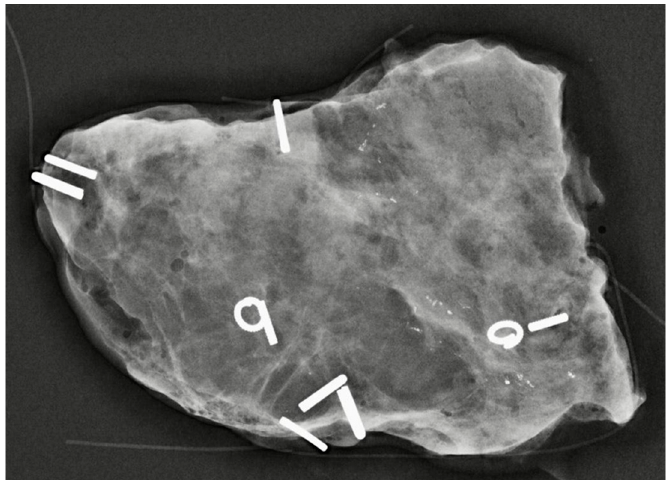
Figure 2. Intra-operative specimen mammogram showing residual micro-calcification after NST for triple-positive invasive breast cancer associated with DCIS with orientation staples in situ. The patient had BCS and the final histology confirmed pCR. There was no DCIS associated with the micro-calcifications seen. The patient remains disease-free three years after surgery.